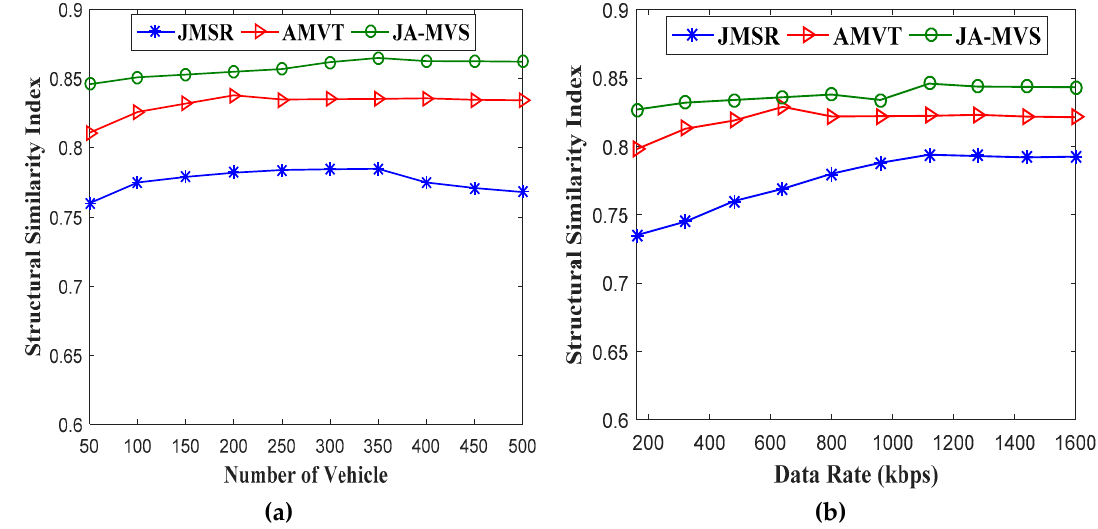
Figure 6. Structural Similarity Index based on ( a ) varied numbers of vehicles and ( b ) data rates.